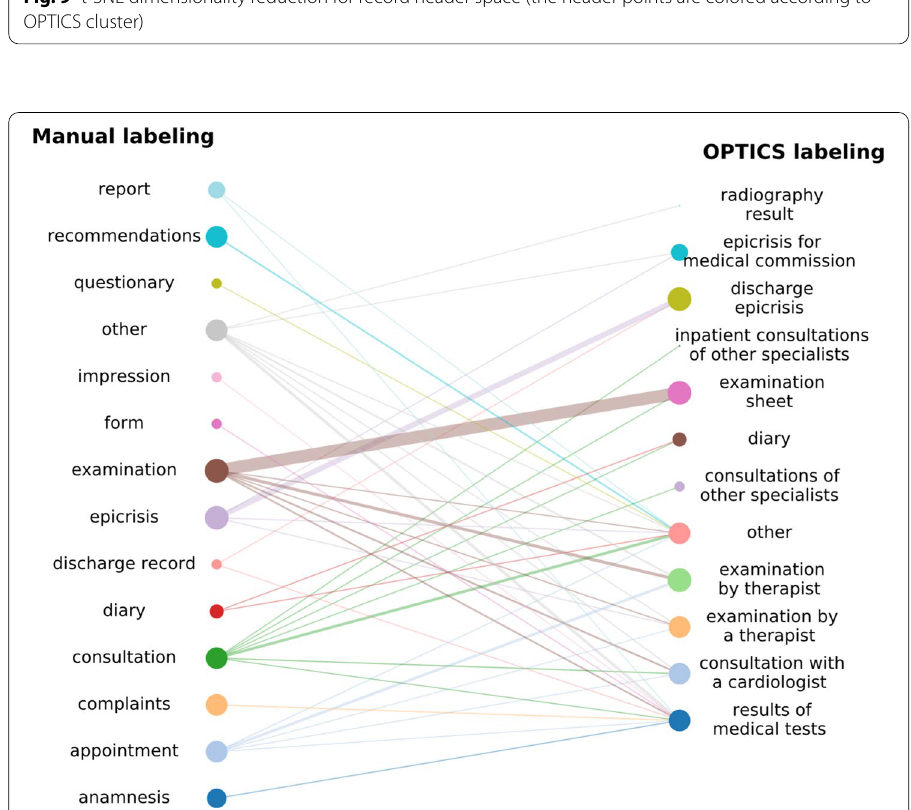
Fig. 10 Distribution of records by manual clusters and OPTICS clusters